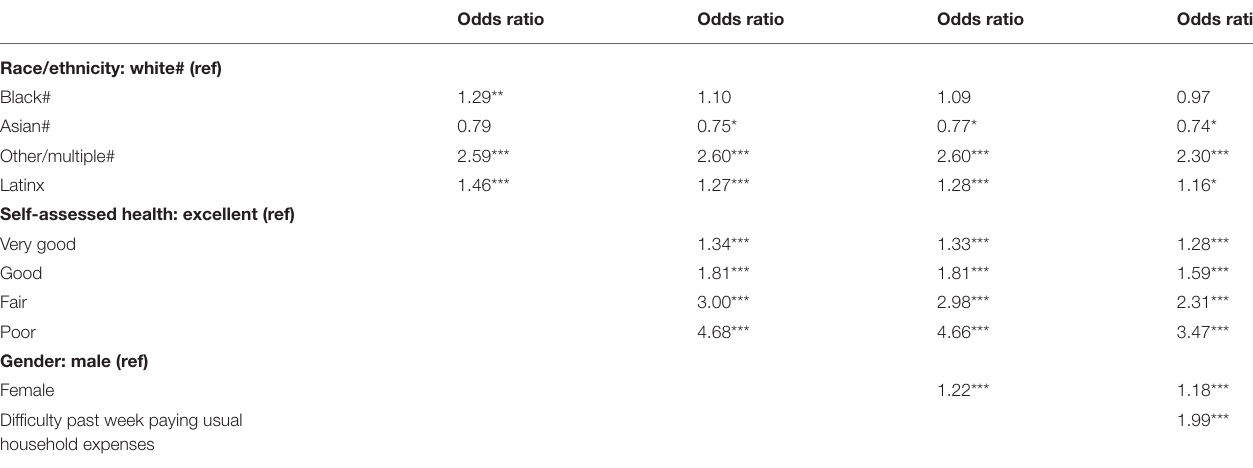
TABLE 8 | Logistic regression of adults ages 65 and over who delayed or did not get medical care past 4-weeks due to COVID-19 pandemic, US, December 2020. Odds ratio Odds ratio Odds ratio Odds